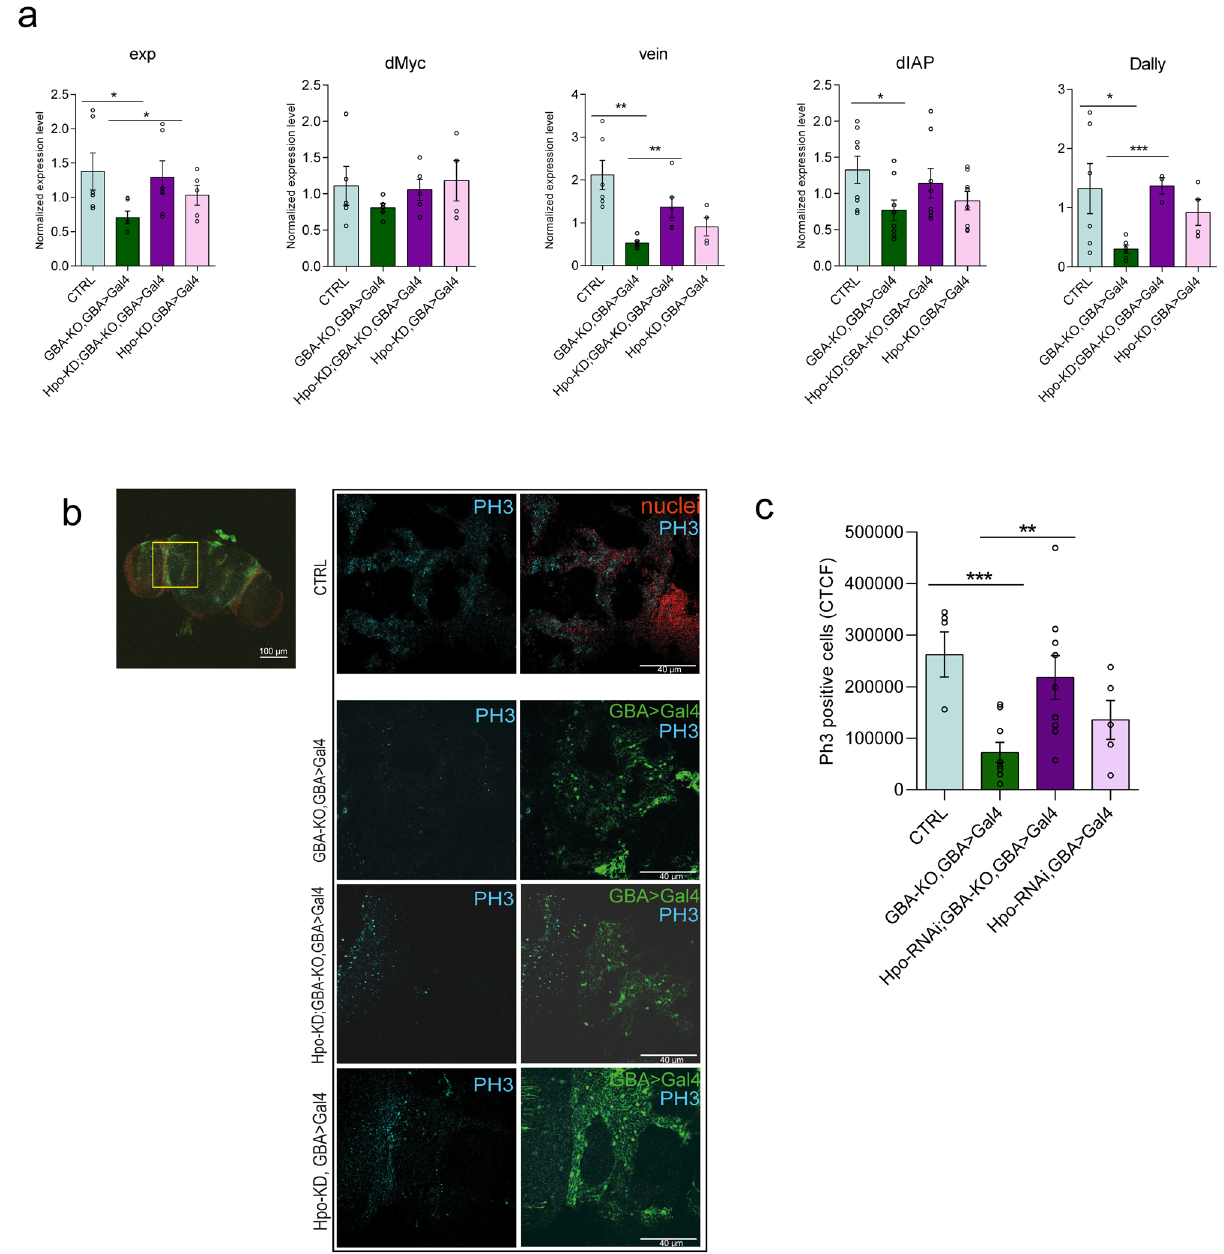
Fig. 5 Hpo-KD rescues the proliferative impairment observed in GBA-KO adult brains. a In the GBA-KO heads the expression level of Yki targets expanded, dMyc, vein, dIAP, and dally, are decreased, whereas in the Hippo interference context, they are restored to wt levels. qRT-PCR performed on the RNA extracted from control fl ies (CTRL — w 1118 in light blue), GBA-KO (in blue), Hpo interference GBA-KO (in purple), and Hpo-KD, GBA > Gal4 (in pink) heads three days after hatching. * p < 0.05; * *p < 0.01; *** p < 0.001. b Immuno fl uorescence against PH3 performed on w 1118 (CTRL), GBA-KO, GBA > Gal4; Hpo-KD, GBA-KO, GBA > Gal4, and Hpo-KD, GBA > Gal4. The analysed area of the fl y brain is indicated with a square in a CTRL brain. Scale bar: 100 µ m. The portion of the organ is zoomed in the images (60X magni fi cation). PH3 staining is shown in cyan, while in the merged pictures, nuclei are in red for the CTRL and GBA > Gal4 cells are marked in green with the endogenous GFP. Scale bar: 40 µ m. c Quanti fi cation of PH3 positive cells performed with the CTCF method. ** p < 0.01, *** p < 0.001. All graphs show mean values and SEM. Statistical signi fi cance is indicated as p value (Student ’ s t -test). Methods (Vienna Drosophila Resource Centre — VDRC n°104169); UAS- luc KD (luc-RNAi Fly stocks, fl y rearing, and genetic manipulation . Fly stocks used in this study BDSC n°35788) used as a reference in the RNAi experiments. Each fl y stock used was grown on the same medium at 25 °C. Only the are w 1118 (indicated as CTRL); Gba1b KO (GBA-KO), the homozygous knockout experiments involving the Minute and engrailed fl ies were performed at 29°C. (KO) obtained from the L. Partidge Lab 22 ; Gba1b-Gal4 (Bloomington Drosophila Stock Center — BDSC n°78943), that have been used in combination with one copy of GBA-KO, in order to create a heteroallelic KO with the Gal4 promoter (GBA- Adult retina fl uorescence evaluation . Using GMR > Gal4 as speci fi c retina pro- KO, GBA> Gal4). To induce GBA KD, the following strains were used: Gba1b KD (GBA-RNAi, moter and UAS-mCD8::GFP, as GFP driver, the head of the adult fl ies of GBA -KO, UAS- GBA -RNAi (one copy each), and UAS- luc -RNAi as control, were cut at BDSC n°38970); Minute , engrailed -Gal4, UAS-GFP, produced in our laboratory different time points, in order to evaluate the fl uorescence associated with ( M,en ); GMR -Gal4 (BDSC n°1104); UAS-mCD8::GFP (BDSC n°5137); UAS- hpo KD COMMUNICATIONS BIOLOGY| (2023) 6:431 |https://doi.org/10.1038/s42003-023-04813-2|www.nature.com/commsbio